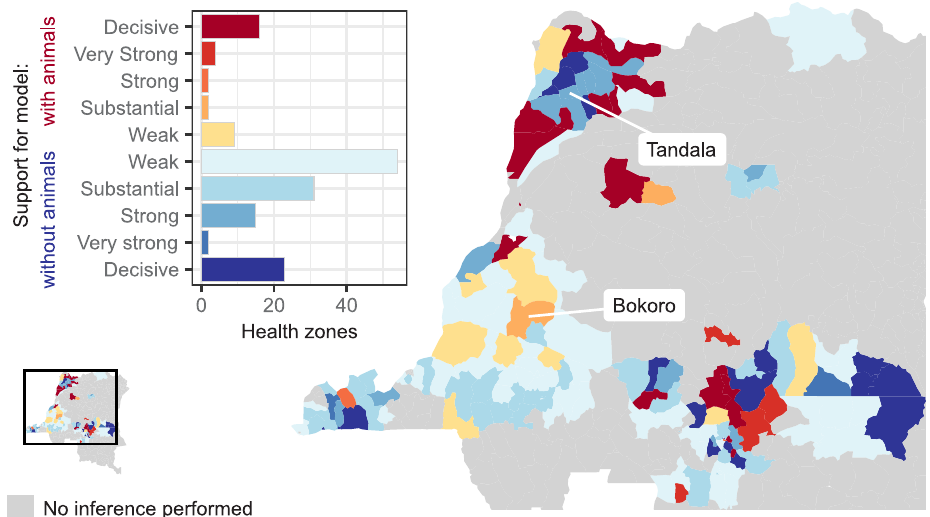
Fig 3. Support for model either with or without animals contributing to transmission of gHAT. Levels of support taken from whichever of the two Bayes Factors (BF, with either evidence for the model with or without animal transmission as the denominator) exceeded 1. Weak, 10 0 < BF < 10 1 2 ; Substantial, 10 1 2 < BF < 10 1 ; Strong, 10 1 < BF < 10 3 2 ; Very Strong, 10 3 2 < BF < 10 2 ; and Decisive, BF > 10 2 . Health zones used as examples in later figures, Bokoro and Tandala, are indicated. Shapefiles used to produce this map were provided by Nicole Hoff and Cyrus Sinai under a CC-BY licence (current versions can be found at